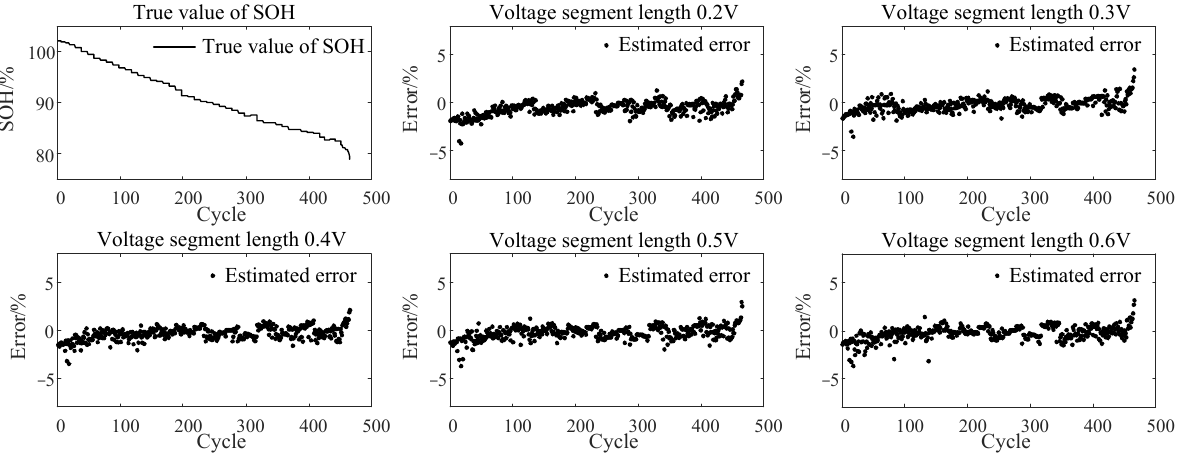
Figure 8. SOH estimation results under 1.0 C discharge.